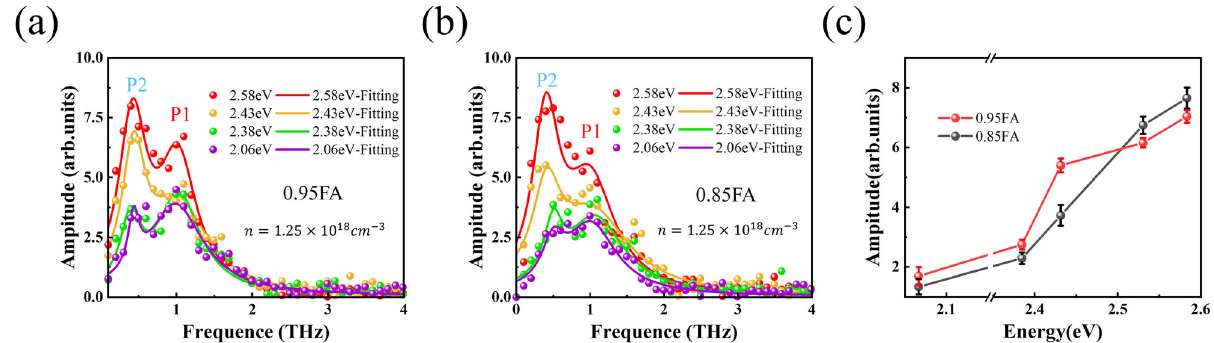
Fig. 3 | The substitution effect on the polaron emission modes. a Amplitude spectrumoftheemittedTHz fi eldform0.95FAexhibitingtwodistinctpeaksat~0.4 and~1THz,thesolidlineusesLorentz fi tting; b Amplitudespectrumoftheemitted